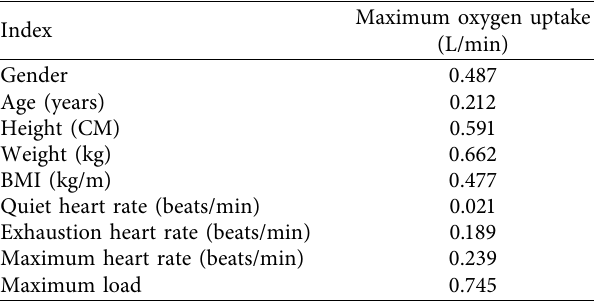
Table 2: Correlation coefficient between each index tested by subjects and maximum oxygen uptake.